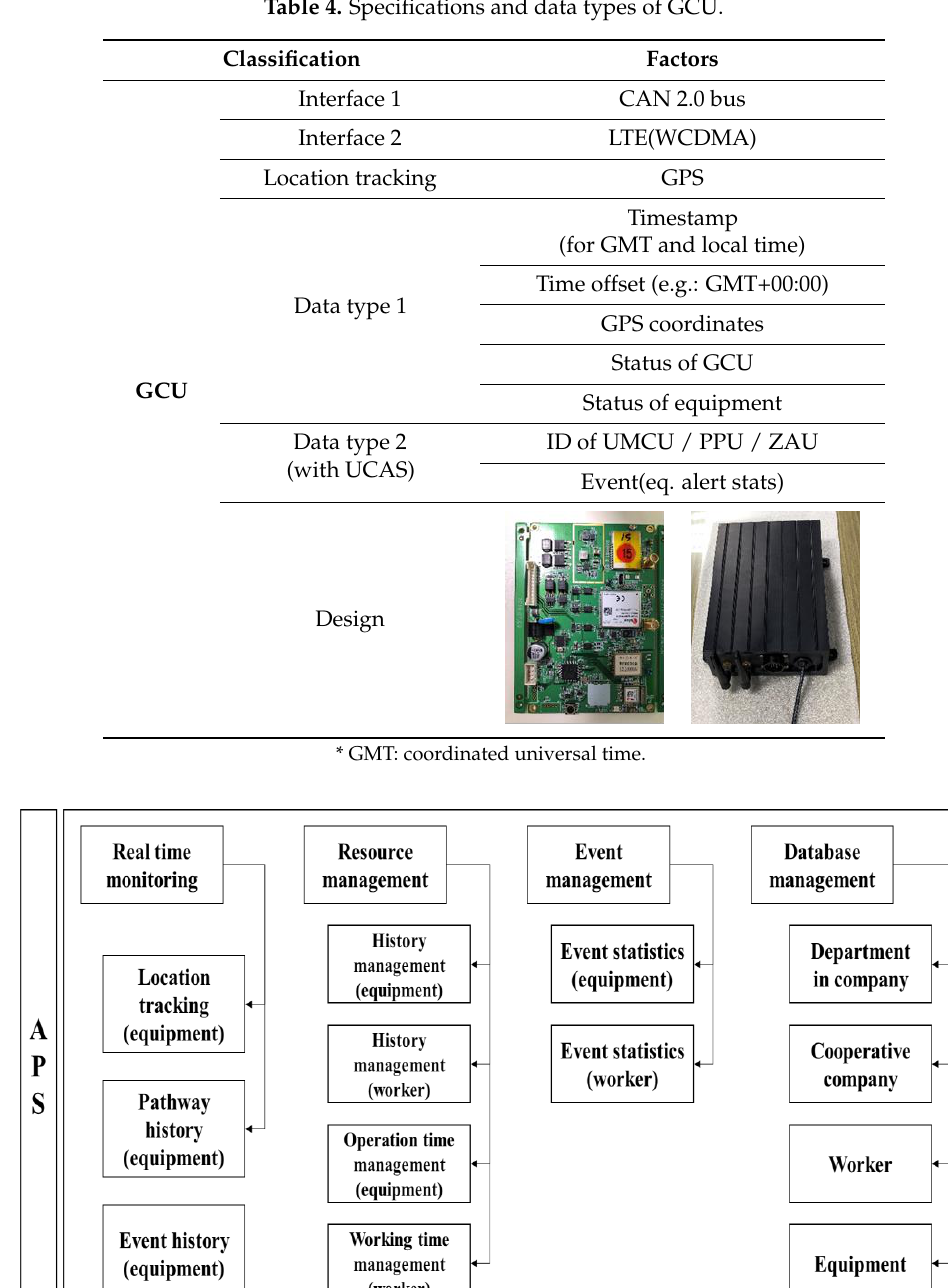
Table 4. Specifications and data types of GCU.